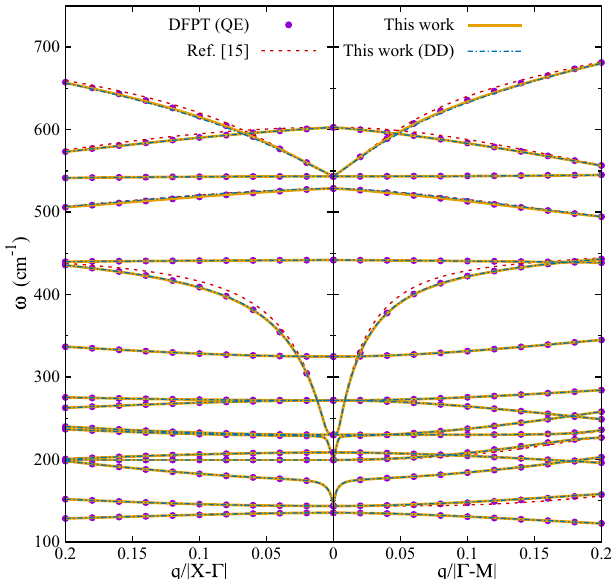
FIG. 7. BaTiO 3 membrane. Dispersion of the optical phonon branches in the long-wavelength limit along the X- Γ and Γ -M segments. The interpolated frequencies are obtained from the dynamical matrices calculated on a grid of 8 × 8 in-plane q